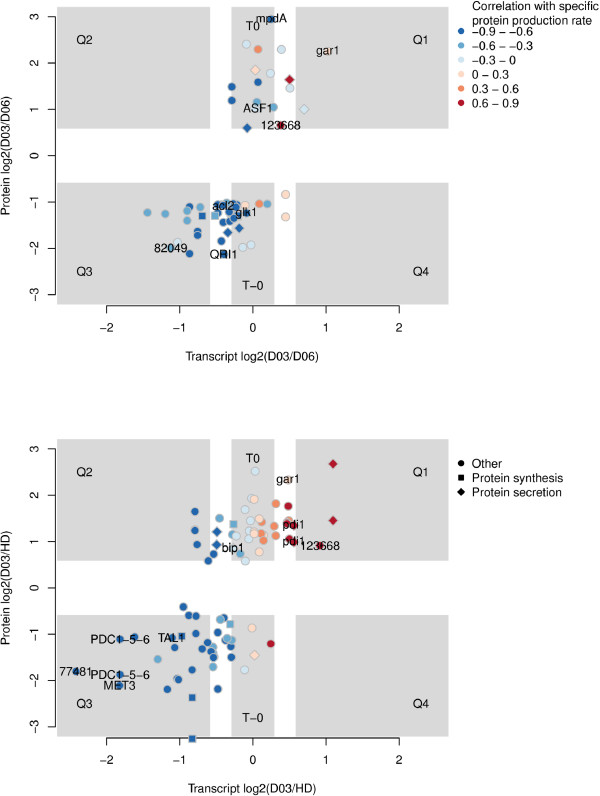
Correlation between transcriptomics and proteomics data. The Y axis shows the log2 fold change of protein expression and the × axis the corresponding transcript expression. Upper panel shows a comparison between D = 0.03 h-1 low cell density (D03) and D = 0.06 h-1 low cell density (D06) and lower panel between D03 and D = 0.03 h-1 high cell density (HD). Data points are coloured based on gene expression's correlation to specific protein production rate. Central crosshairs shows the 1.5 (0.6 as log2) fold change cut-off for both axes. In addition, a half of that on log2 scale i.e. 1.2 (0.3 as log2) was used as cut-off for 'non-transcriptionally regulated' assingment (T0, T-0). Q1-4 label the quadrants of transcript-protein relationship classification. Same cut-offs were used for enrichment analysis of proteomics (Table 3) and transcript-protein relationship classification (Additional file 1, Table S10).